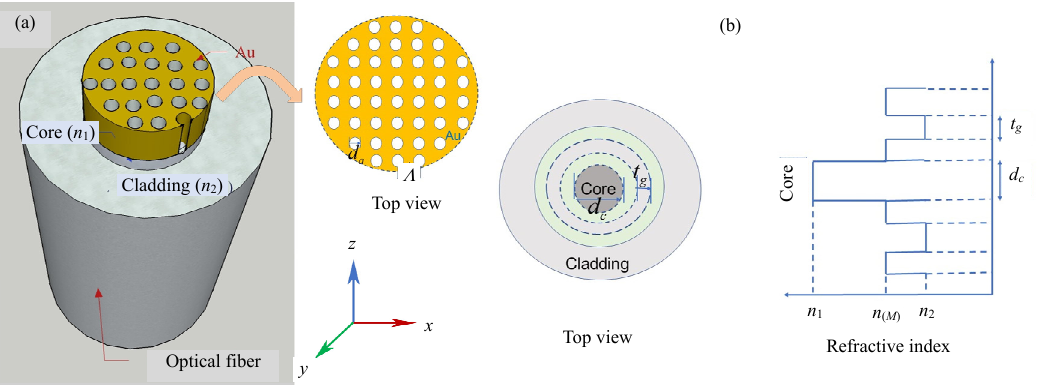
Fig. 1 Schematic diagram of the optical sensor with Au circular aperture arrays on a C-C Bragg fiber facet: (a) 3D view of the structure and (b) top view of the structure and RI variation with radial distance of rectangular solid core Bragg